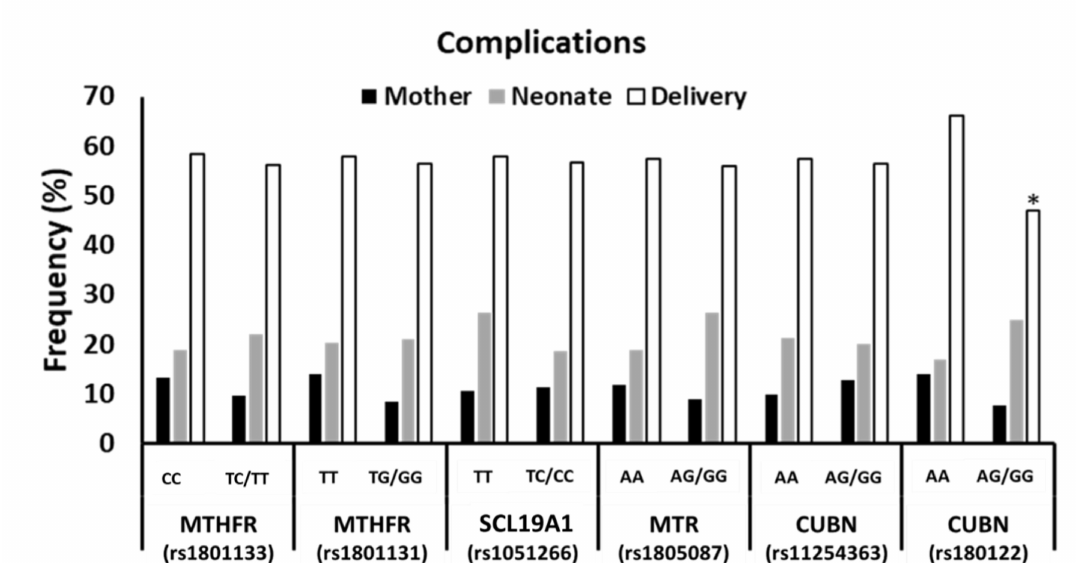
Figure 2. Association between complications in health of the mother, that of the neonate, or during delivery and SNP genotypes of genes related to folate and cobalamin metabolism and transport in the study population. (*) indicates statistically significant differences in delivery complications (white bars) between both groups of genotypes (AA vs. AG/GG). AA, adenine-adenine genotype; AG, adenine-guanine genotype; GG, guanine-guanine genotype; TT, thymine-thymine genotype; TG, thymine-guanine genotype; CC, cytosine-cytosine geno-type; TC, thymine-cytosine genotype; MTHFR, methylenetetrahydrofolate reductase; SLC10A1, reduced folate carrier (RFC1); MTR, me- thionine synthase; CUBN,